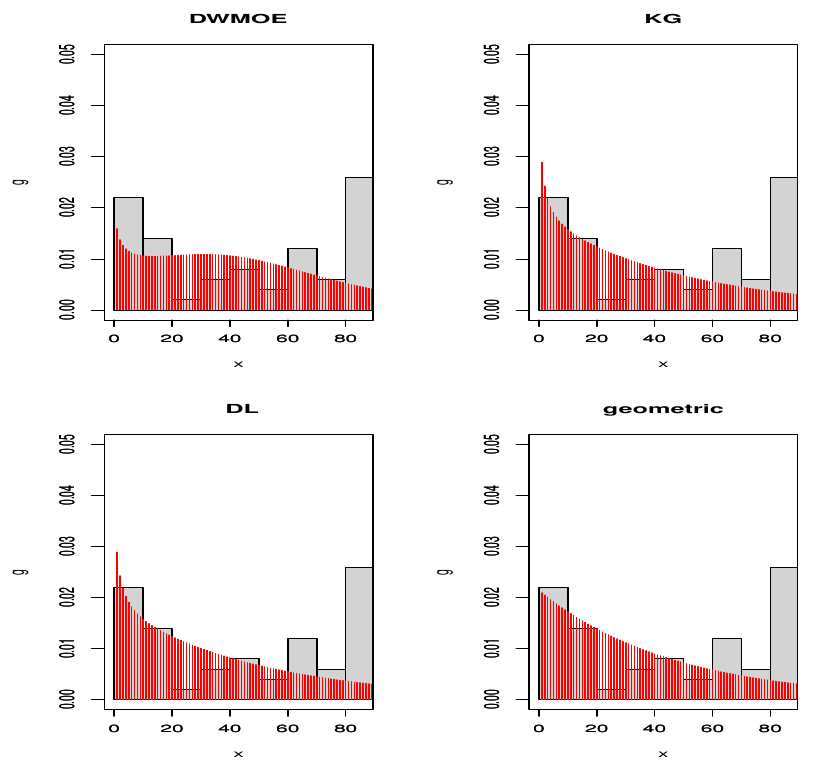
Figure 4. Plots of estimated pdfs of distributions for Data set